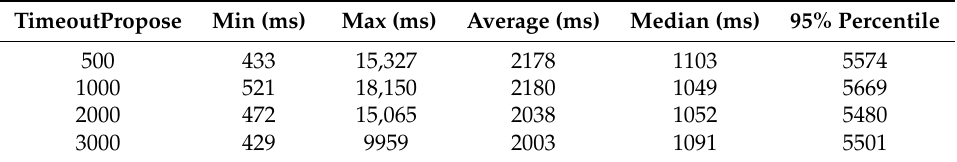
Table 6. Network latency with 4 producer nodes under failure assumption.